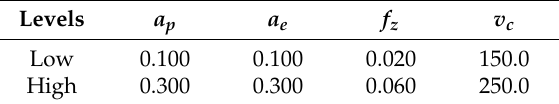
Table 2. Low and high levels for factors a e , a p , f z and v c .